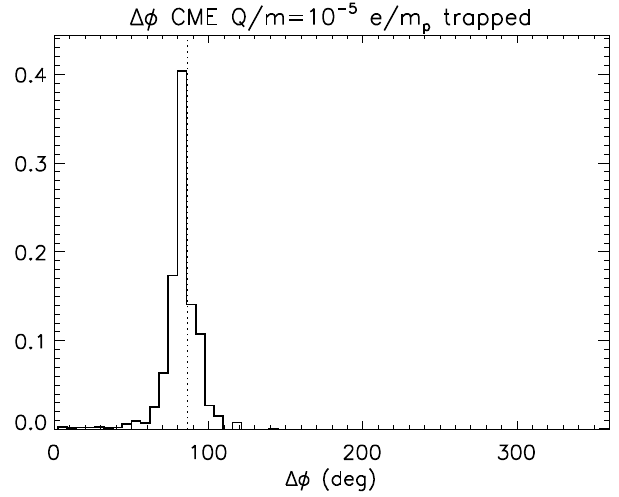
Figure 16. Distribution of the difference (cid:49)φ between the final and initial values of the heliographic longitude φ for the particles in the “trapped” class for the case of the time-extended (6.11 days long) CME model. The vertical dotted line shows the value of (cid:49)φ corre- sponding to solar rotation over 6.11 days.